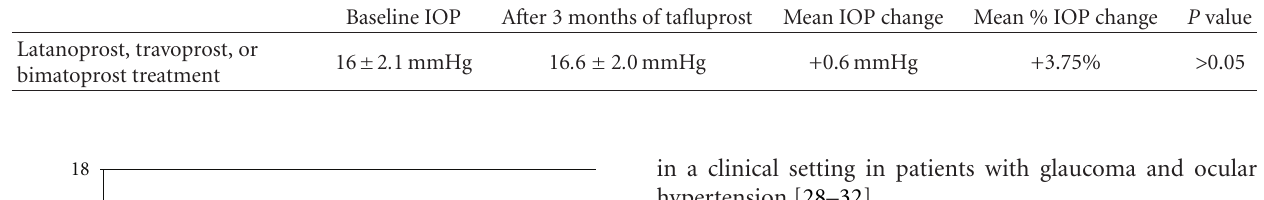
Table 1: Mean daily IOP at baseline and after 3 months of treatment with tafluprost.